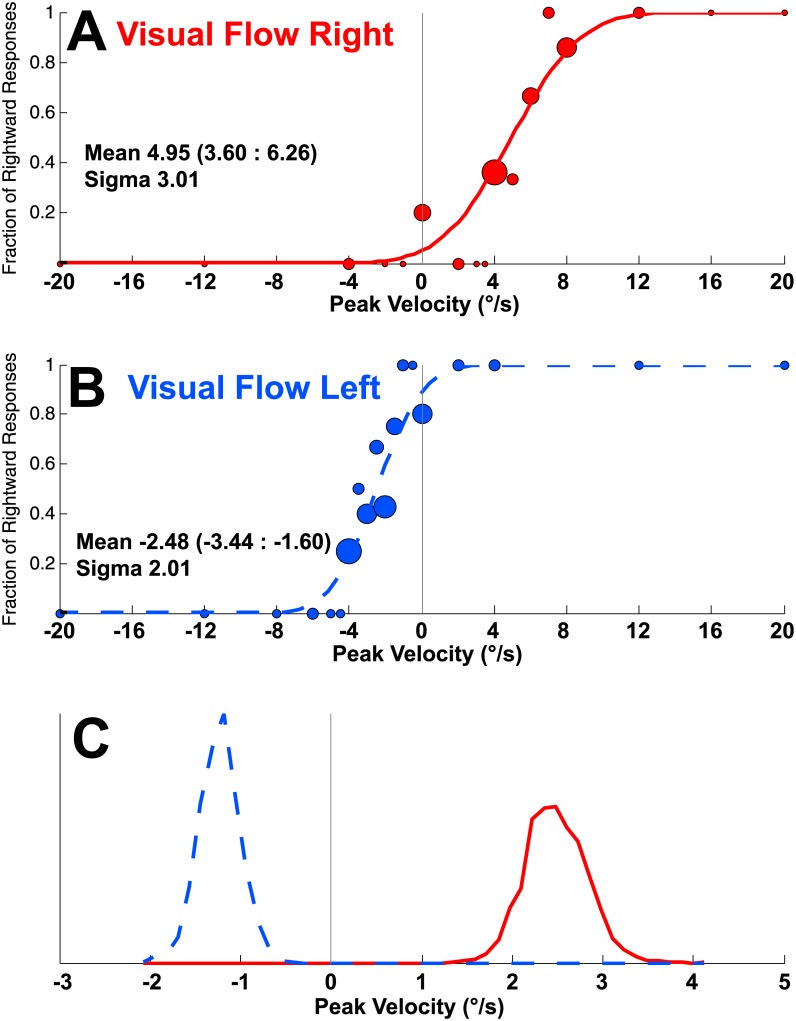
Sample data from an individual subject (#1) during a block of trials in which there was rotatory visual motion and a rotatory inertial stimulus.The circles in panels A&B represents the test stimuli given at a peak velocity with the diameter of the dot proportional to the number of responses at that stimulus level (the smallest dots represent a single stimulus and the largest 10 stimuli). The best fit cumulative distribution function (CDF) to the data is shown for each visual stimulus direction. (A) Responses to stimuli in which the visual stimulus moved to the right (implying leftward rotation in a fixed environment). (B) Responses to stimuli in which the visual stimulus moved left. The stimuli in panels A&B were randomly interleaved during the block of trials. (C) The CDF was fit to the data in A & B after being randomly resampled 2,000x. The mean was calculated for each iteration. The histograms of these means demonstrate no overlap between the two distributions.